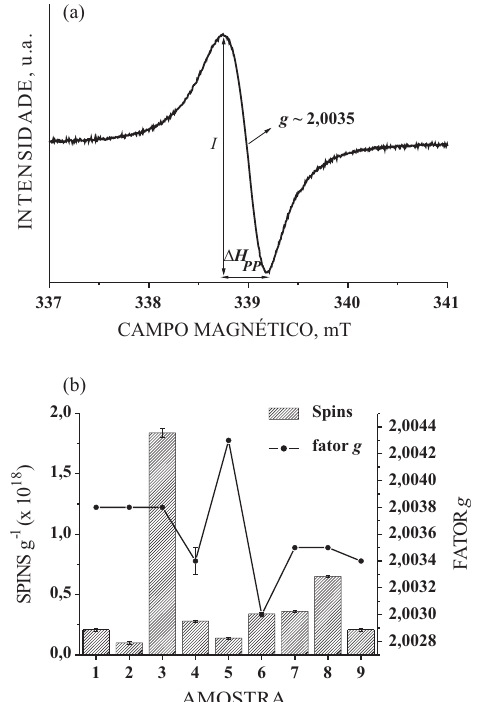
Figura 1. Espectro característico de RPE dos adubos orgânicos (amostra 7), mostrando o sinal do RLO (a) e a concentração de RLO (em spins g -1 de amostra) e o valor do fator g das diferentes amostras de adubos orgânicos